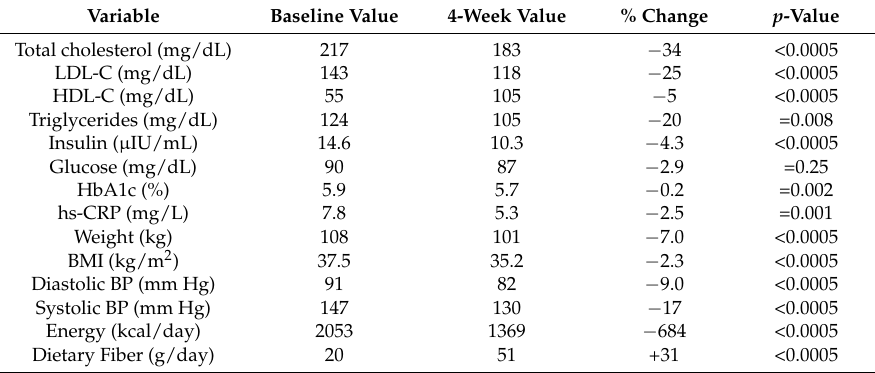
Table 2. Mean change in cardiovascular disease (CVD) risk factors for newly diagnosed CVD patients after a 4-week prevention diet primarily of fruits, vegetables, avocados and seeds [164].